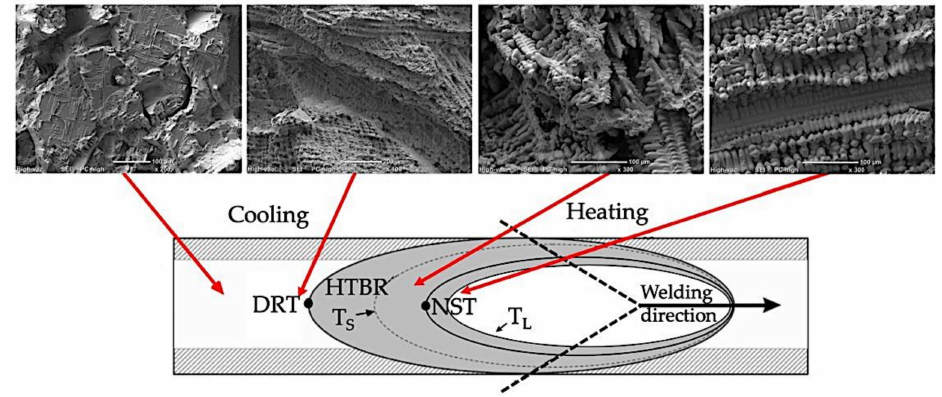
Figure 18. Change in surface morphology on the surface of a crystallisation crack that developed during the remelting of a casting under forced deformation conditions. T Lmax —temperature at the end of the longest